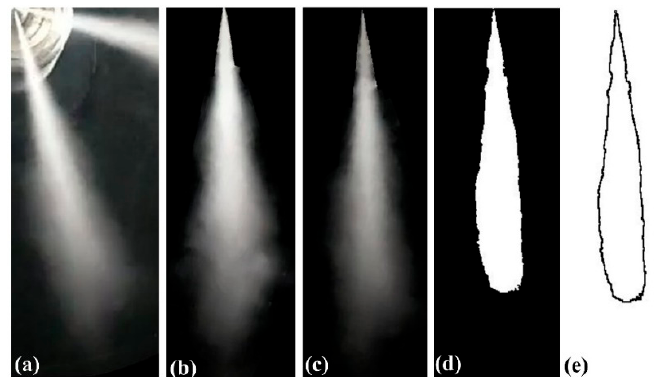
Figure 6. Image processing of fuel spray in a CVV used to find macroscopic spray parameters. ( a ) Raw image, ( b ) processed image with background removed, ( c ) grayscale image, ( d ) binary image, and ( e ) measurement of image after edge detection.